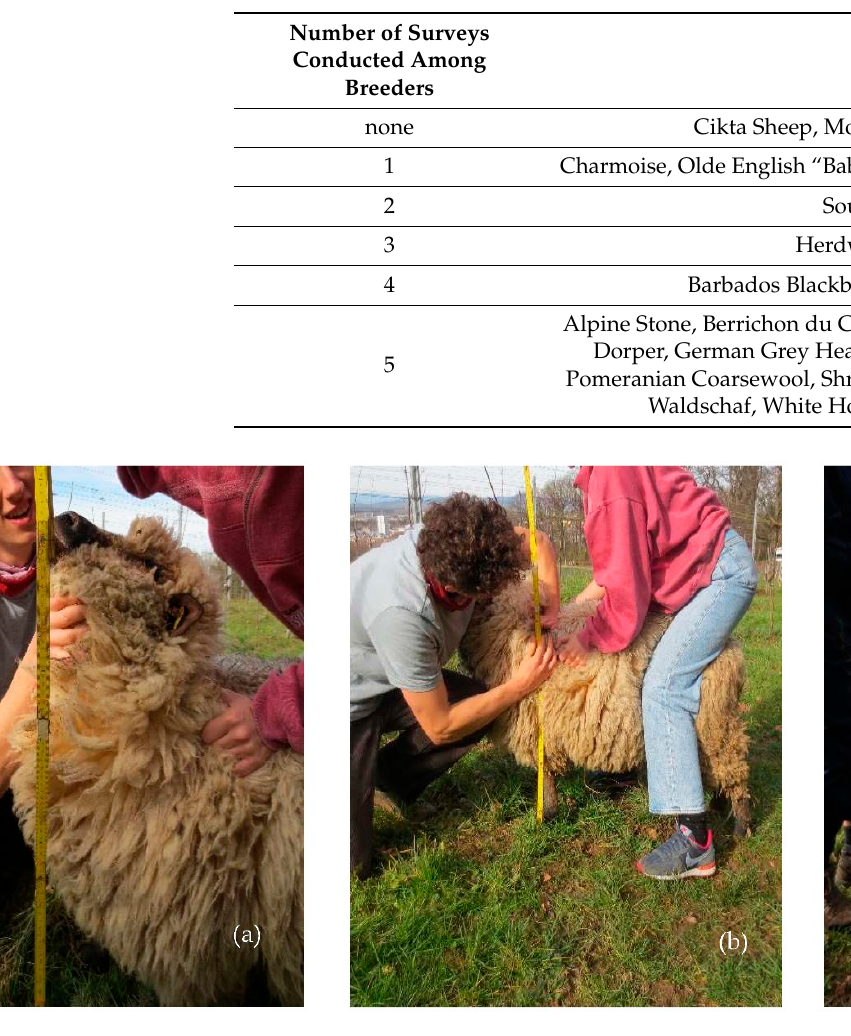
Figure 3. Exemplary measurement of: ( a ) max. grazing height in four-legged stance; ( b ) wither height; and ( c ) max. grazing height in two-legged stance of a Shropshire. Table 1. Information on the procedure for determining the grazing height.